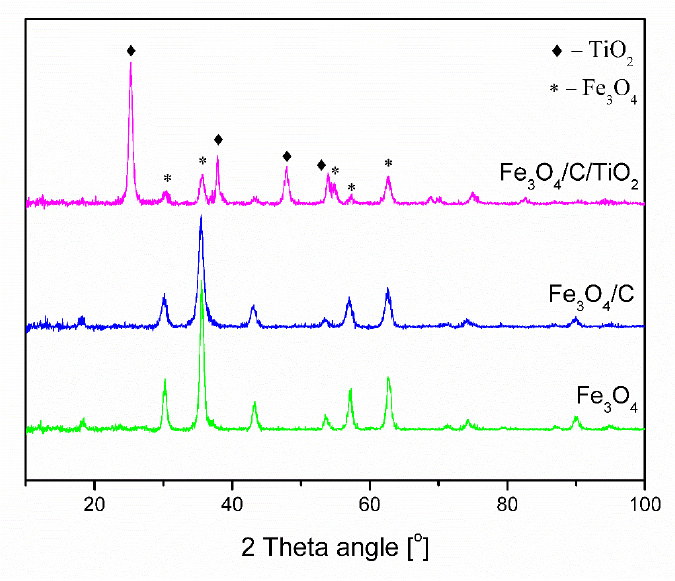
Figure 1. XRD patterns of Fe 3 O 4 , Fe 3 O 4 / C, and Fe 3 O 4 / C / TiO 2 .